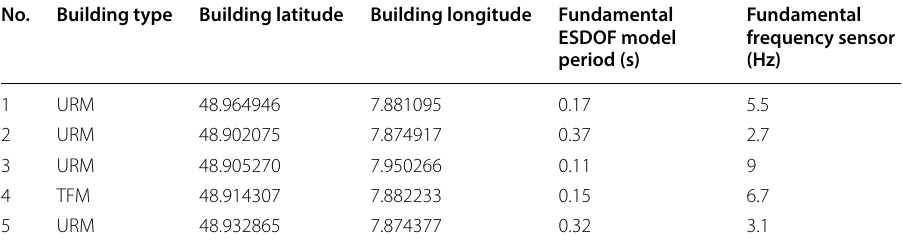
Table 2 Real URM and TFM buildings located near the geothermal platforms in Alsace region in France